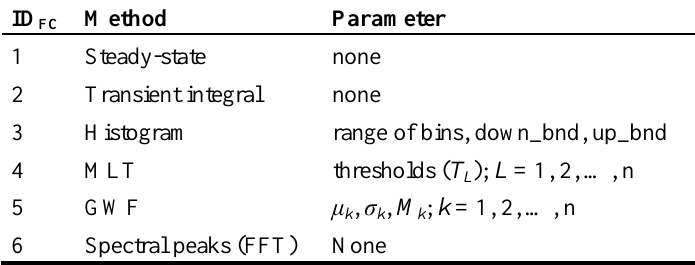
Table 3. List of operators for extracting of features used in sensor signal processing (e.g., gas